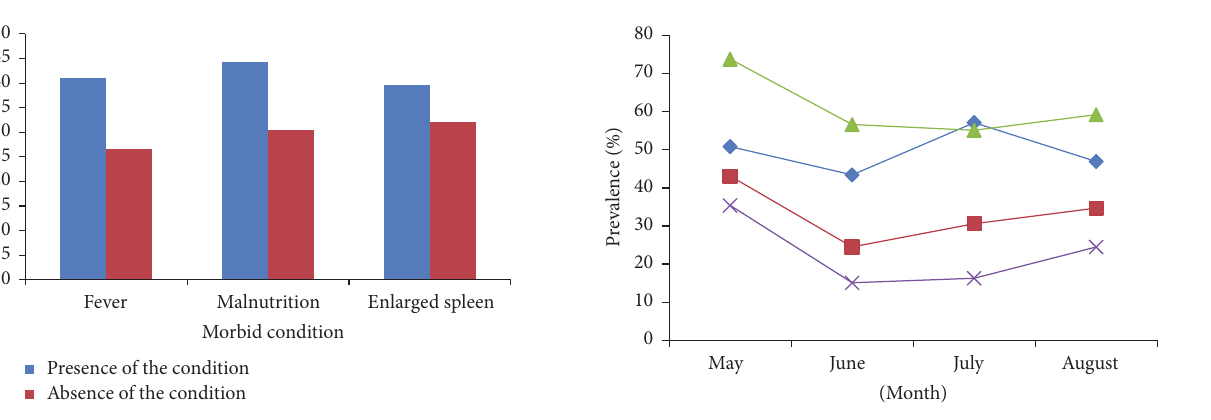
Figure 1: Prevalence of malaria parasite as affected by the status of fever, malnutrition, and splenomegaly. Presence of a morbid condition refers to (i) presence of fever (children with temperature ≥ 37.5 ∘ C) and (ii) presence of malnutrition (children with <− 2 𝑧 scores in one of the anthropometric indices (HA, WA, and WH)) and (iii)presenceofenlarged spleen(children withenlarged spleen). Absence of a condition refers to (i) absence of fever (children with body temperature < 37.5 ∘ C), (ii) absence of malnutrition (well nourished children with >− 2 𝑧 score in all anthropometric indices), and (iii) absence of enlarged spleen (children with normal spleen size).